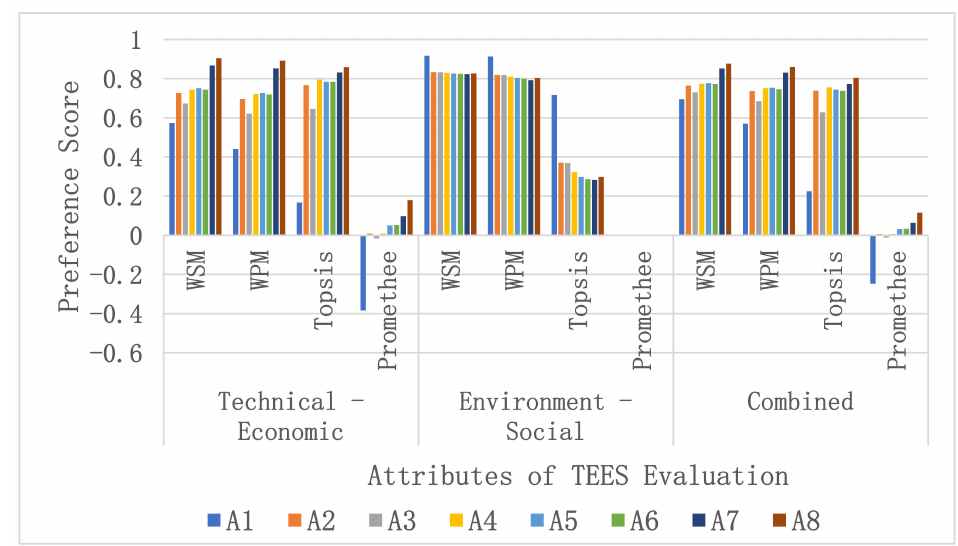
Figure 8. Attributes of TEES evaluation for C1/S1 with DGs only at 0.9 PF under NL.